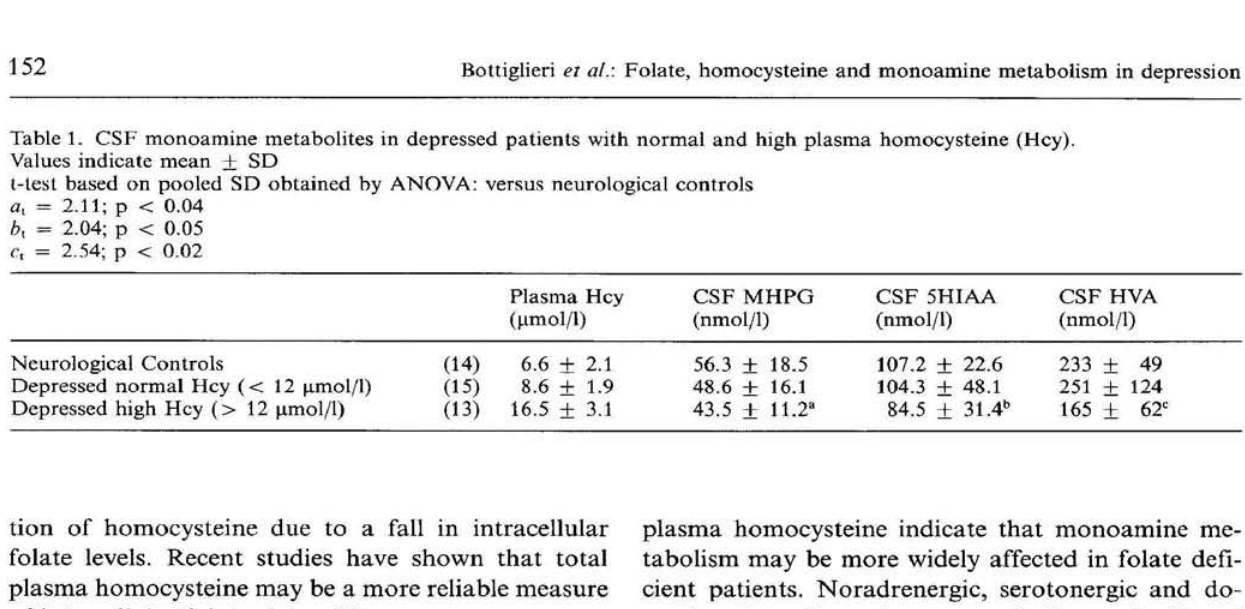
Table 1. CSF monoamine metabolites in depressed patients with normal and high plasma homocysteine (Hey). Values indicate mean + SD t-test based on pooled SD obtained by ANOVA: versus neurological controls a, = 2.11; ρ < 0.04 è, = 2.04; ρ < 0.05 c t = 2.54; ρ <